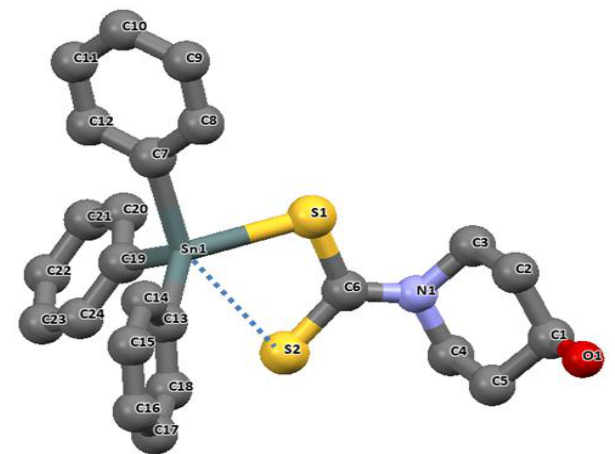
Figure 5. The molecular structure of triphenyltin(IV) 4-hydroxypiperidine dithiocarbamate. (For clarity, H atoms were omitted). Redrawn from [81], with permission from Elsevier (Copyright 2018).